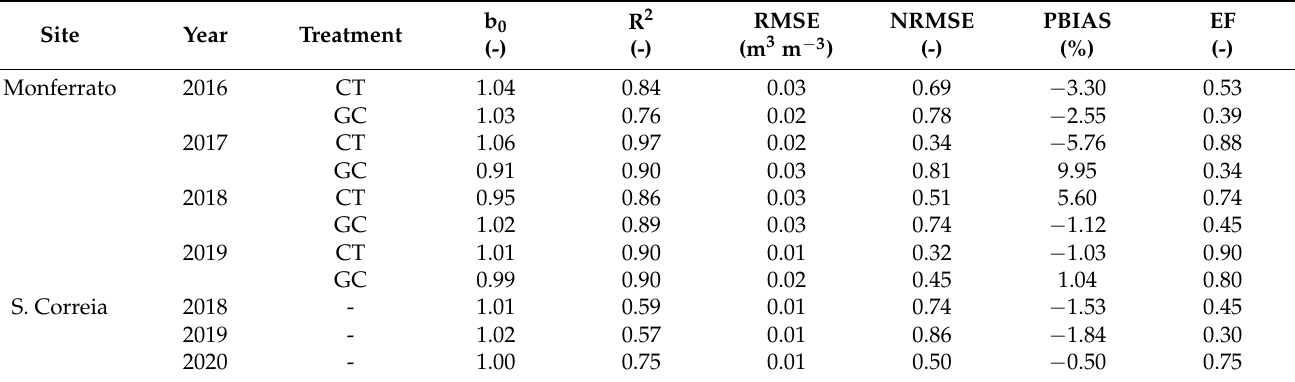
Table 7. Goodness-of-fit indicators for the adjustment between measured and simulated values in all case